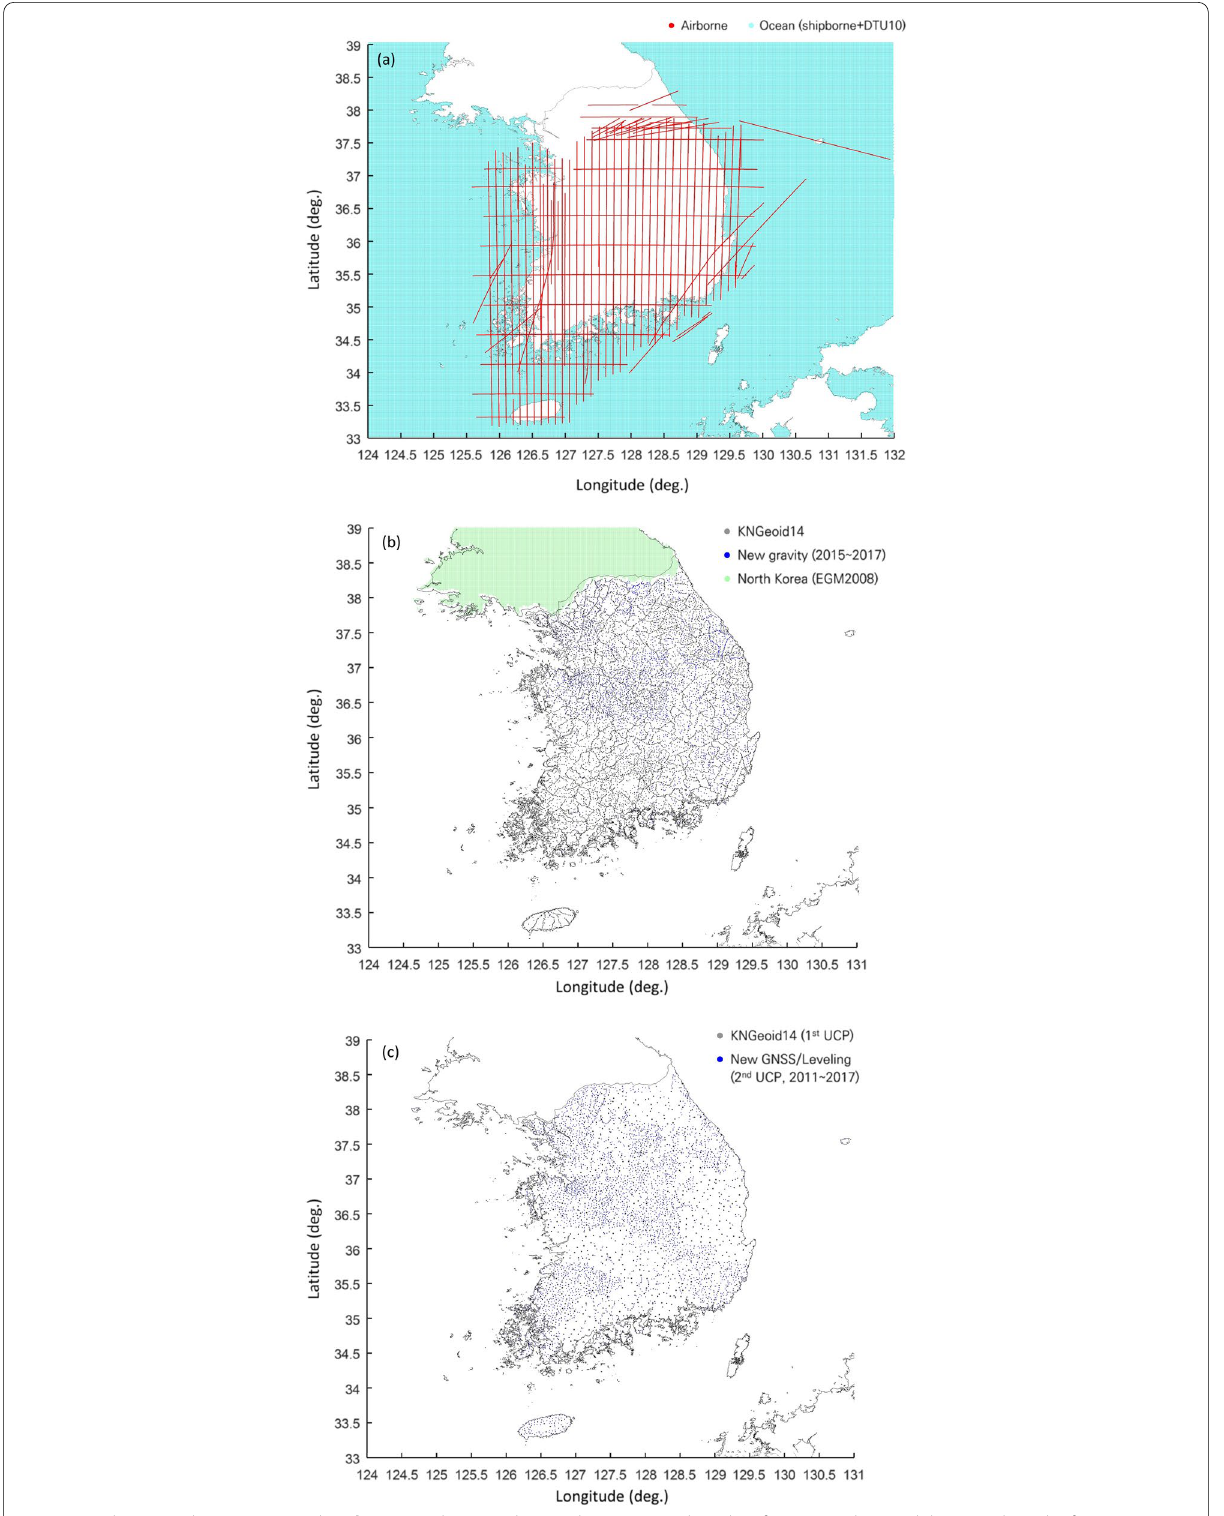
Fig. 5 a Airborne and ocean gravity data, b terrestrial gravity data, and c GNSS/Leveling data for KNGeoid18 modeling [re-plotted referring to products of Kwon et al.